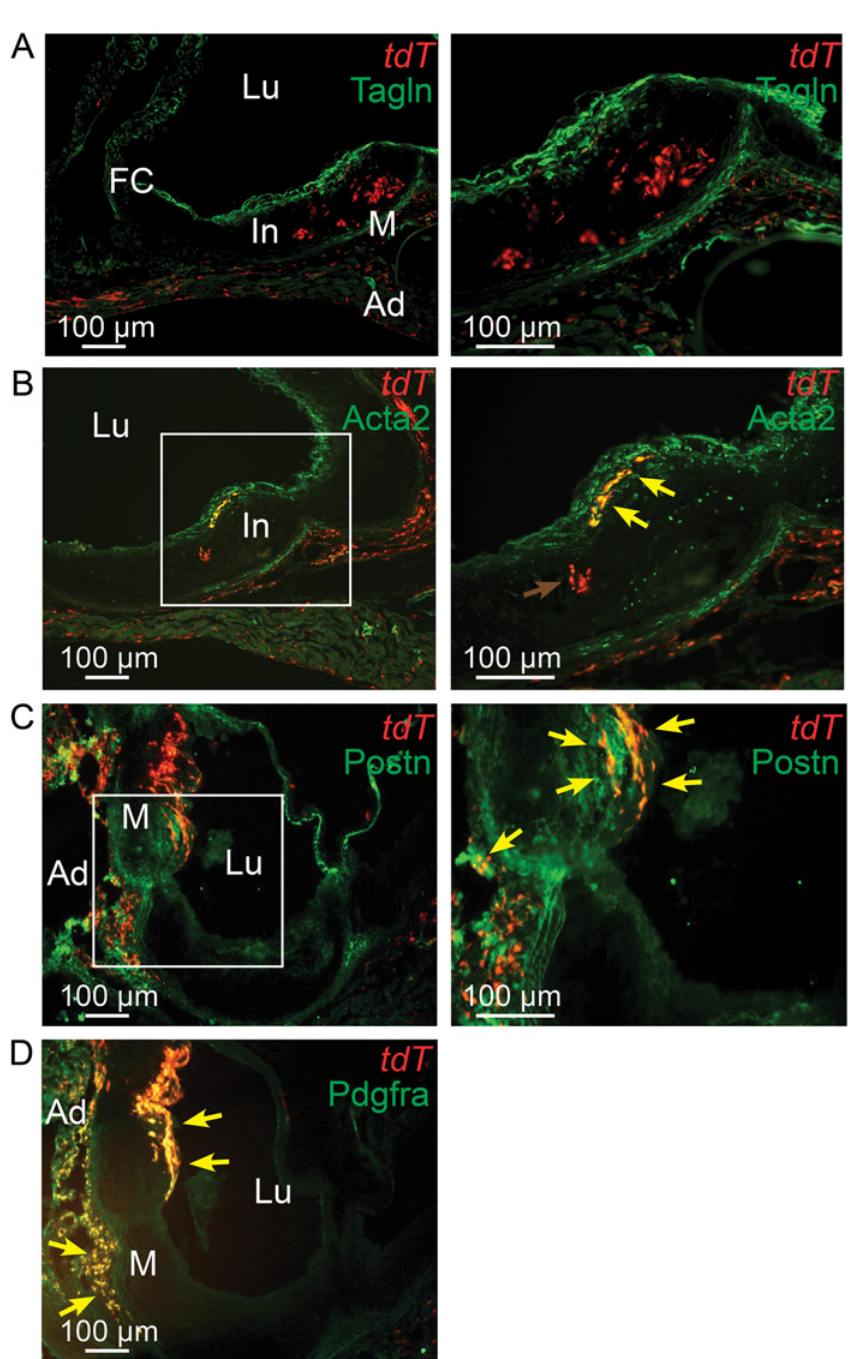
Fig 6. Tcf21 lineage traced cells in Ldlr -/- lesions give rise to smooth muscle cells in the fibrous cap. Tcf21 iCre/+ , Ldlr -/- mice were administered tamoxifen to activate expression of an inducible MerCreMer construct knocked into the Tcf21 locus to produce recombination and thus expression of a floxed STOP tandem dimer tomato (tdT) reporter gene. Animals received tamoxifen chow at 3 – 5 weeks of age and were subsequently fed HFD for 16 – 20 weeks before sacrifice. A) tdT positive cells are seen throughout the lesion and in the adventitia with Tagln staining cells identified in the media and fibrous cap. B) A number of tdT lineage traced cells in the fibrous cap express the SMC marker Acta2 as shown by colocalization of fluorescent markers (yellow arrows). tdT positive cells within the lesion did not express Tagln, as shown by red color (red arrow). C) Some cells in the adventitia stain for periostin expression and colocalize with tdT staining in this location (yellow arrows). Staining for periostin and colocalization with Tcf21 lineage cells